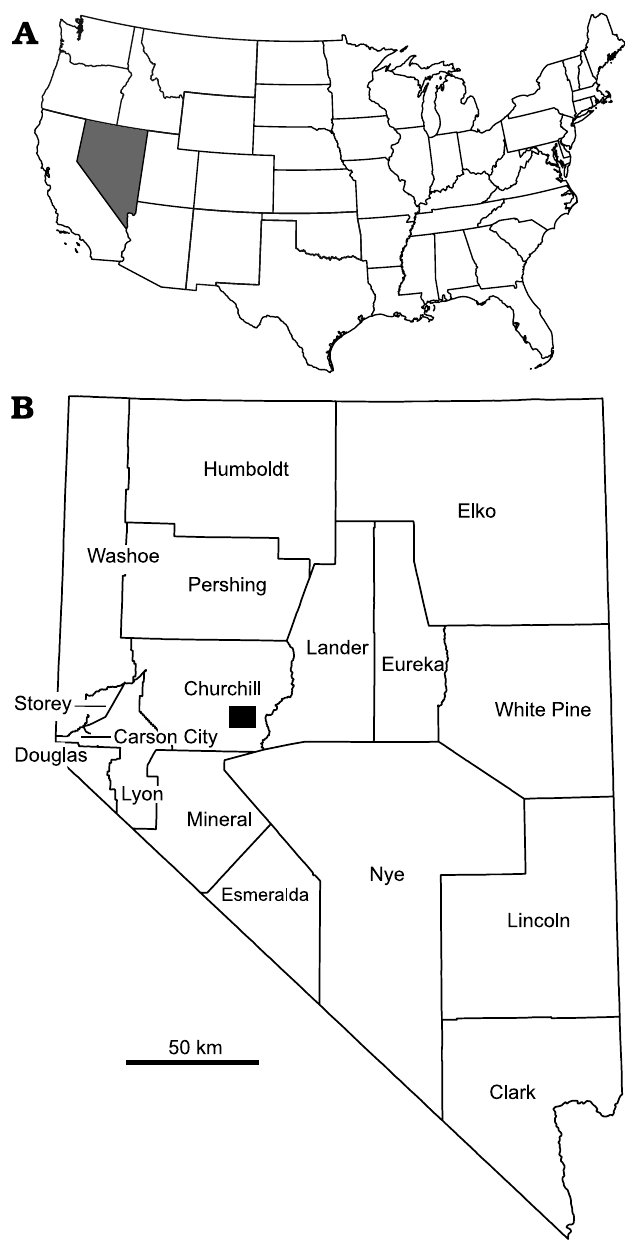
Fig. 1. Location of the study area within USA ( A ) and state of Nevada, Churchill County ( B ), Eastgate study area indicated as black rectangle. Modified from Smith et al.